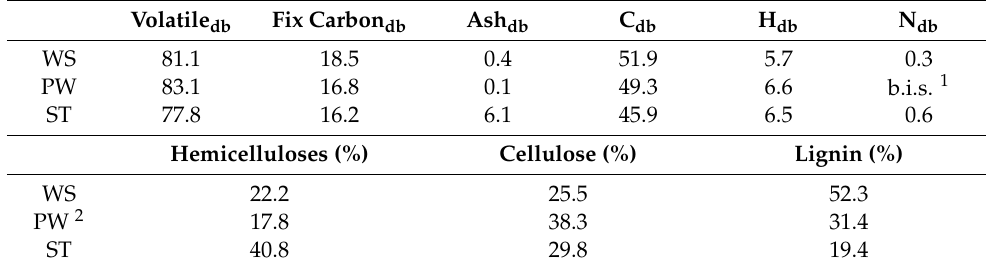
Table 1. Composition of selected biomasses.